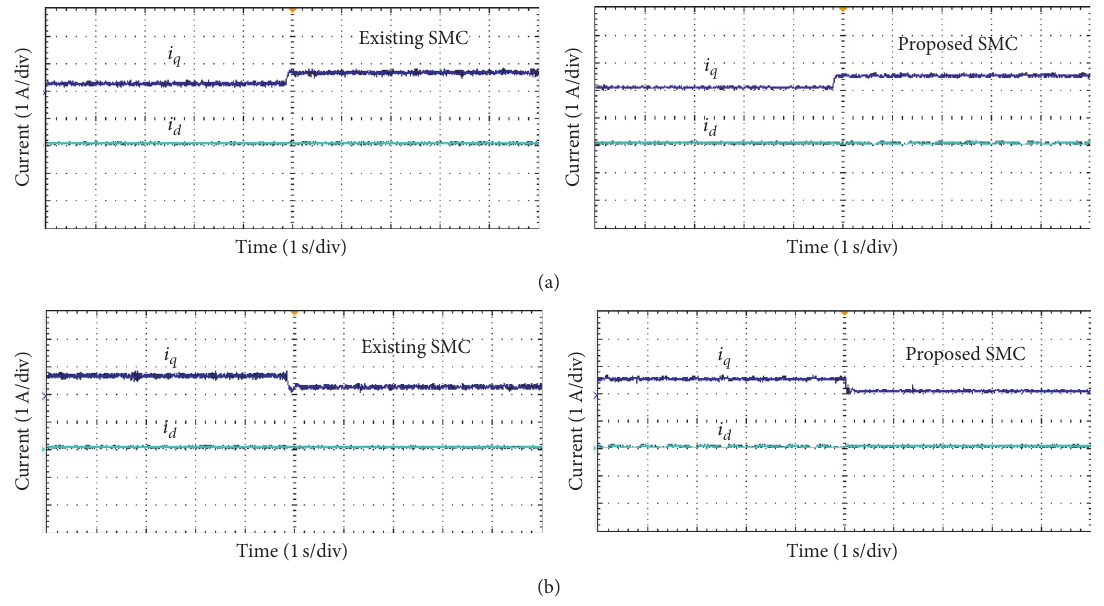
Figure 16: Measured waveforms of currents 𝑖 𝑑 and 𝑖 𝑞 . (a) With increasing load. (b) With decreasing